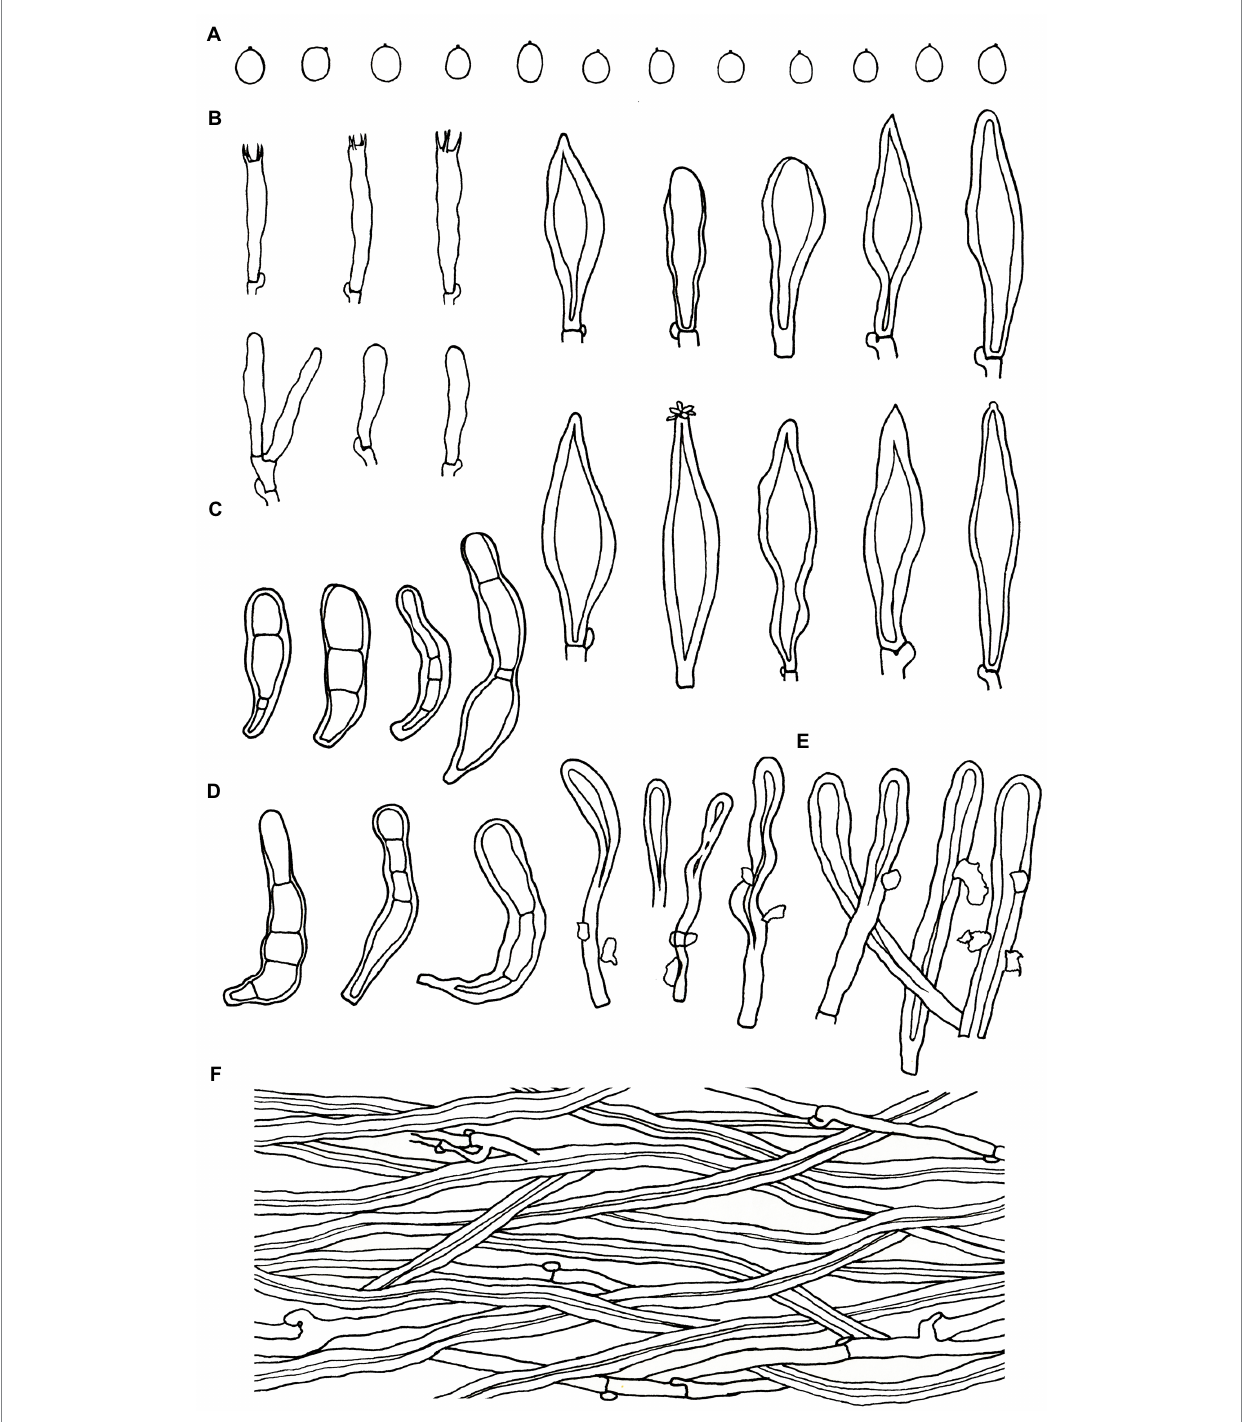
FIGURE 6 Microscopic structures of Podoscypha subinvoluta (140721-10, holotype). (A) Basidiospores, (B) basidia and basidioles, (C) cystidia, (D) pilocystidia, (E) caulocystidia, and (F) hyphae from context. (Bars: (A) = 5 μ m, (B–F) = 10 μ m). Drawn by Hai-Jiao